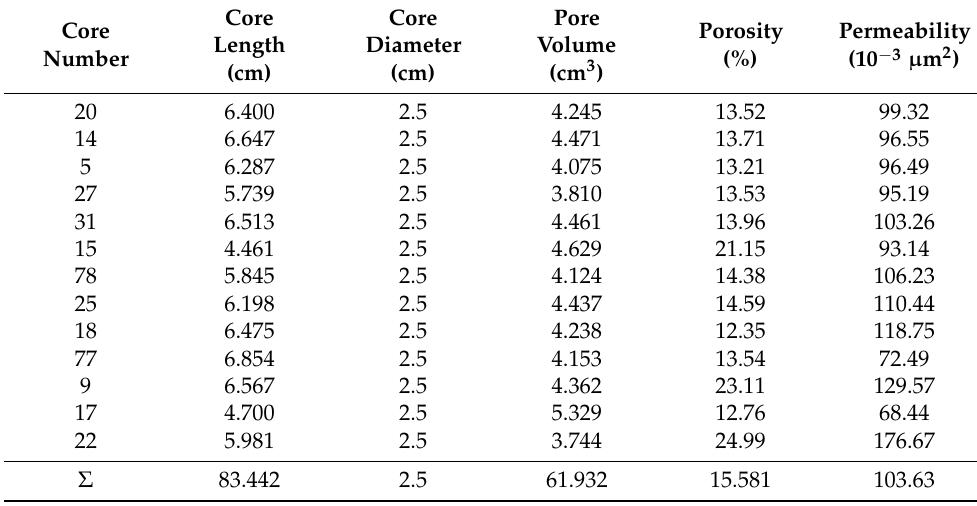
Table 4. Sequence of high permeability long core.